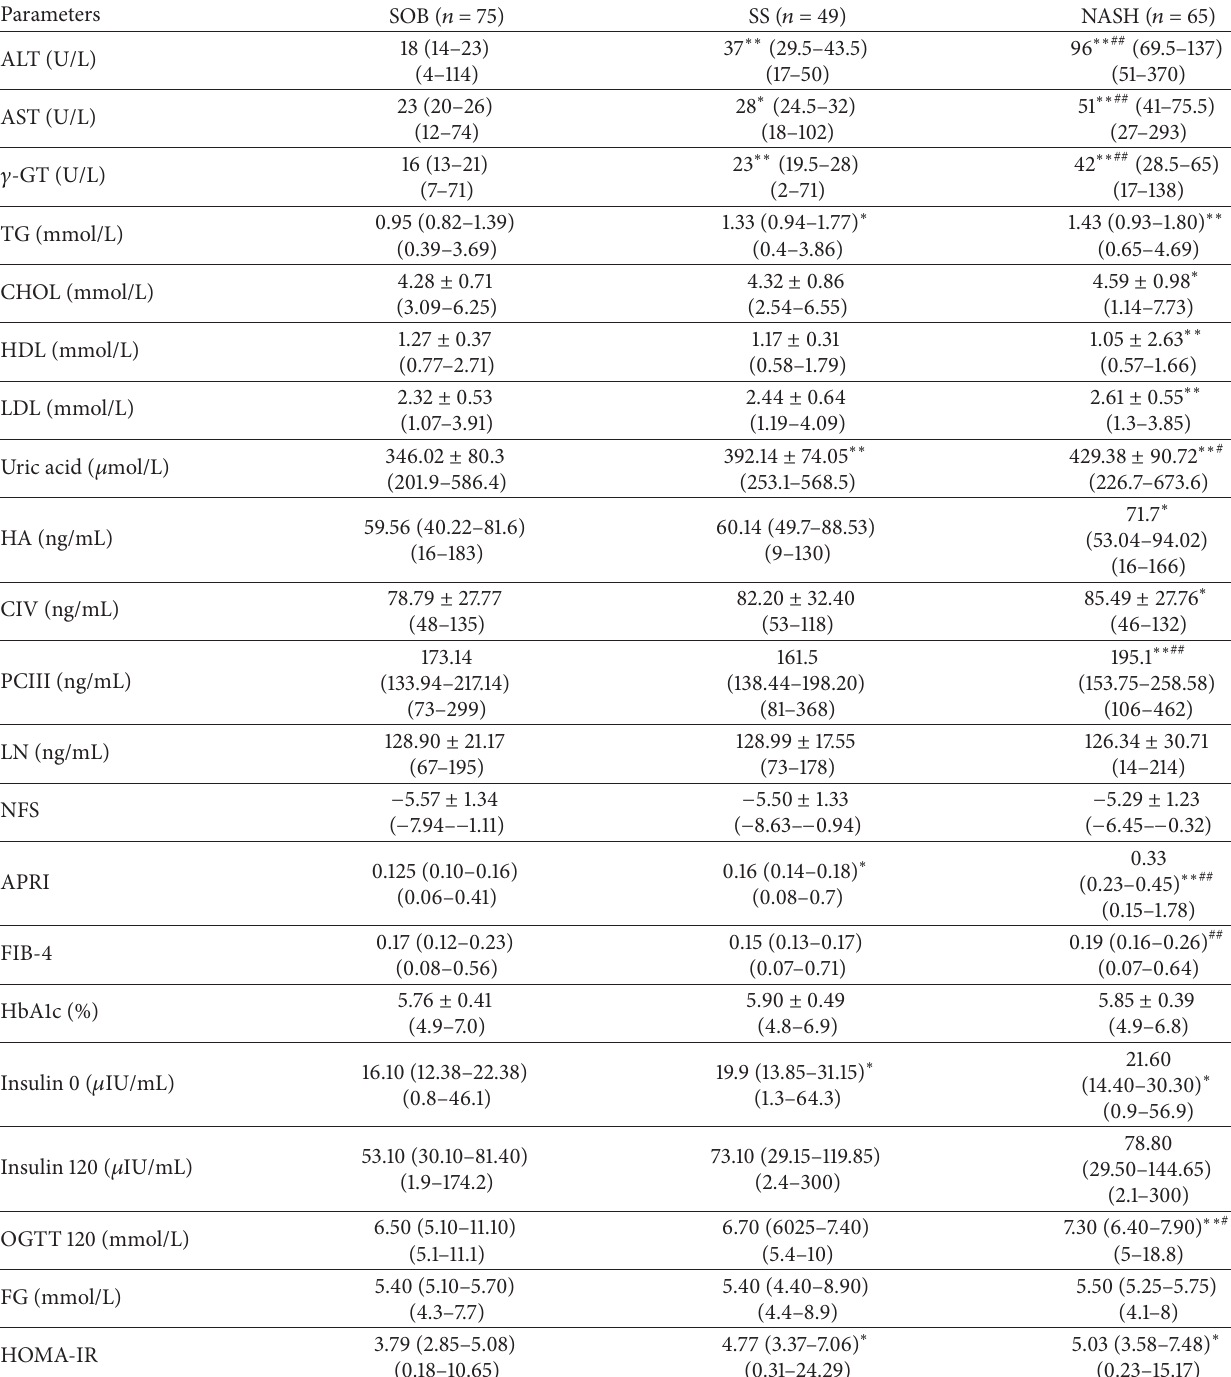
Table 2: Comparison of biochemical